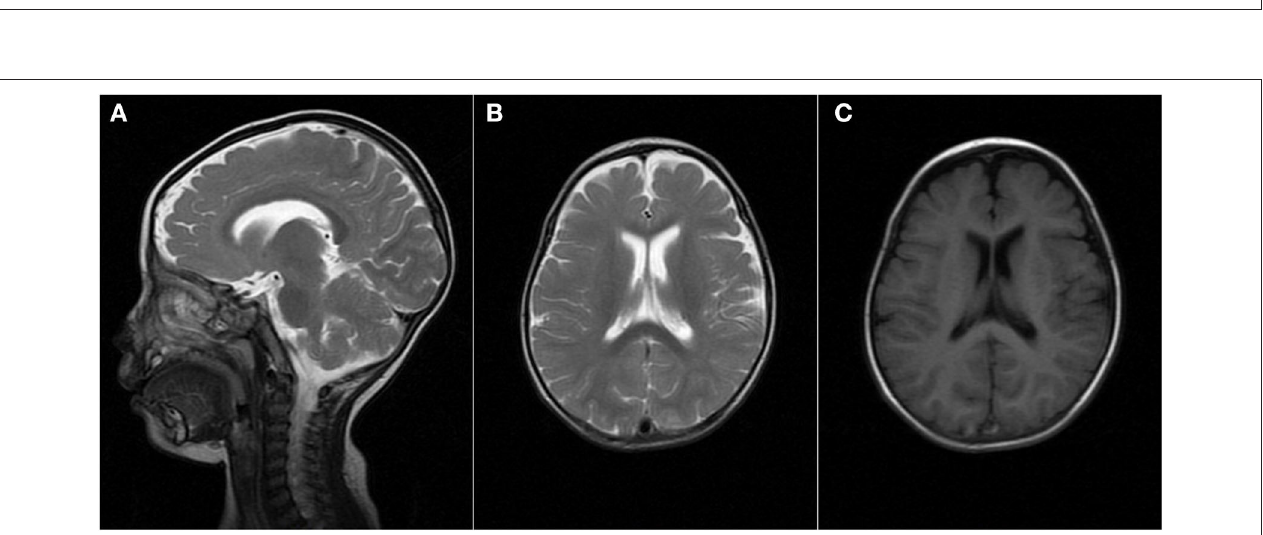
FIGURE 2 | Brain MRI finding at the age of 11 months. MRI [ (A,B) T2, (C) T1] demonstrated the widening of the extracerebral space at the bilateral temporal poles.